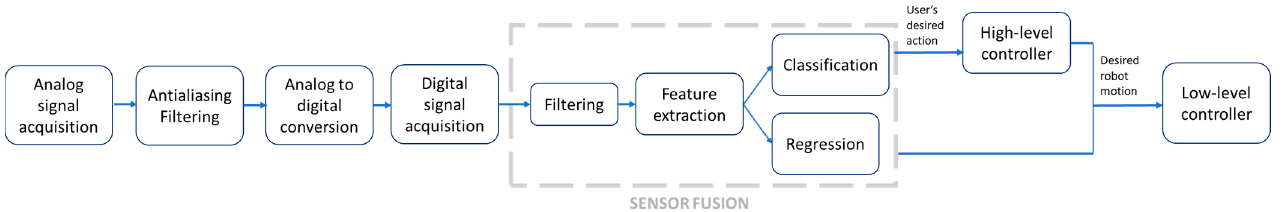
Figure 3. Generic illustration of signal processing and decision-making process in a wearable robot. Adapted with permission from ref. [47]. Copyright 2015 Adapted from Novak et al., 2015 [47].